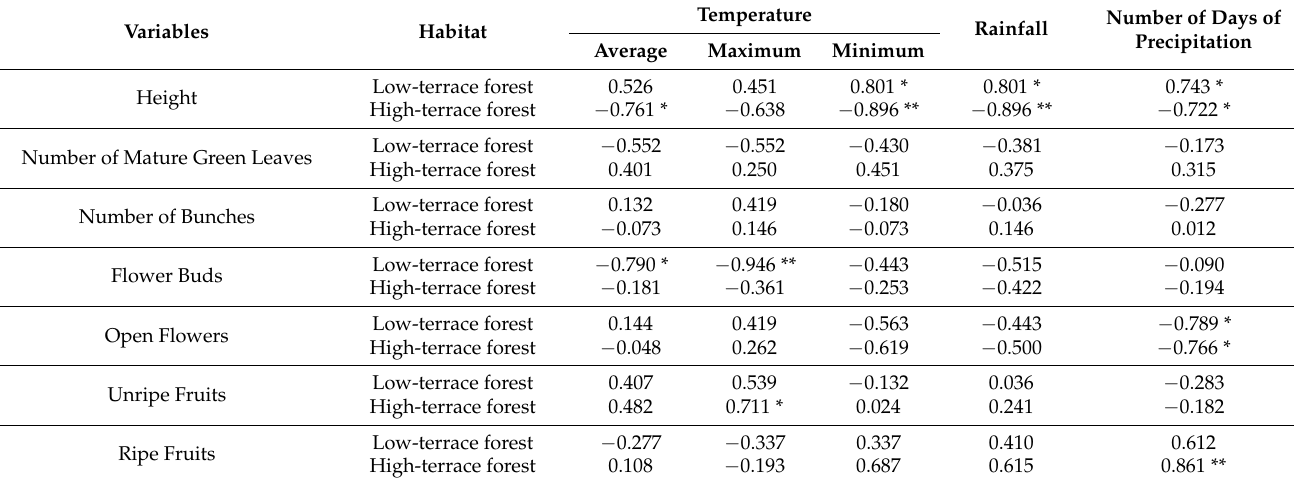
Table 4. Spearman’s correlation coefficients (Rs) between monthly phenological variables and environmental factors in low-terrace and high-terrace forests of the Madre de Dios Region,